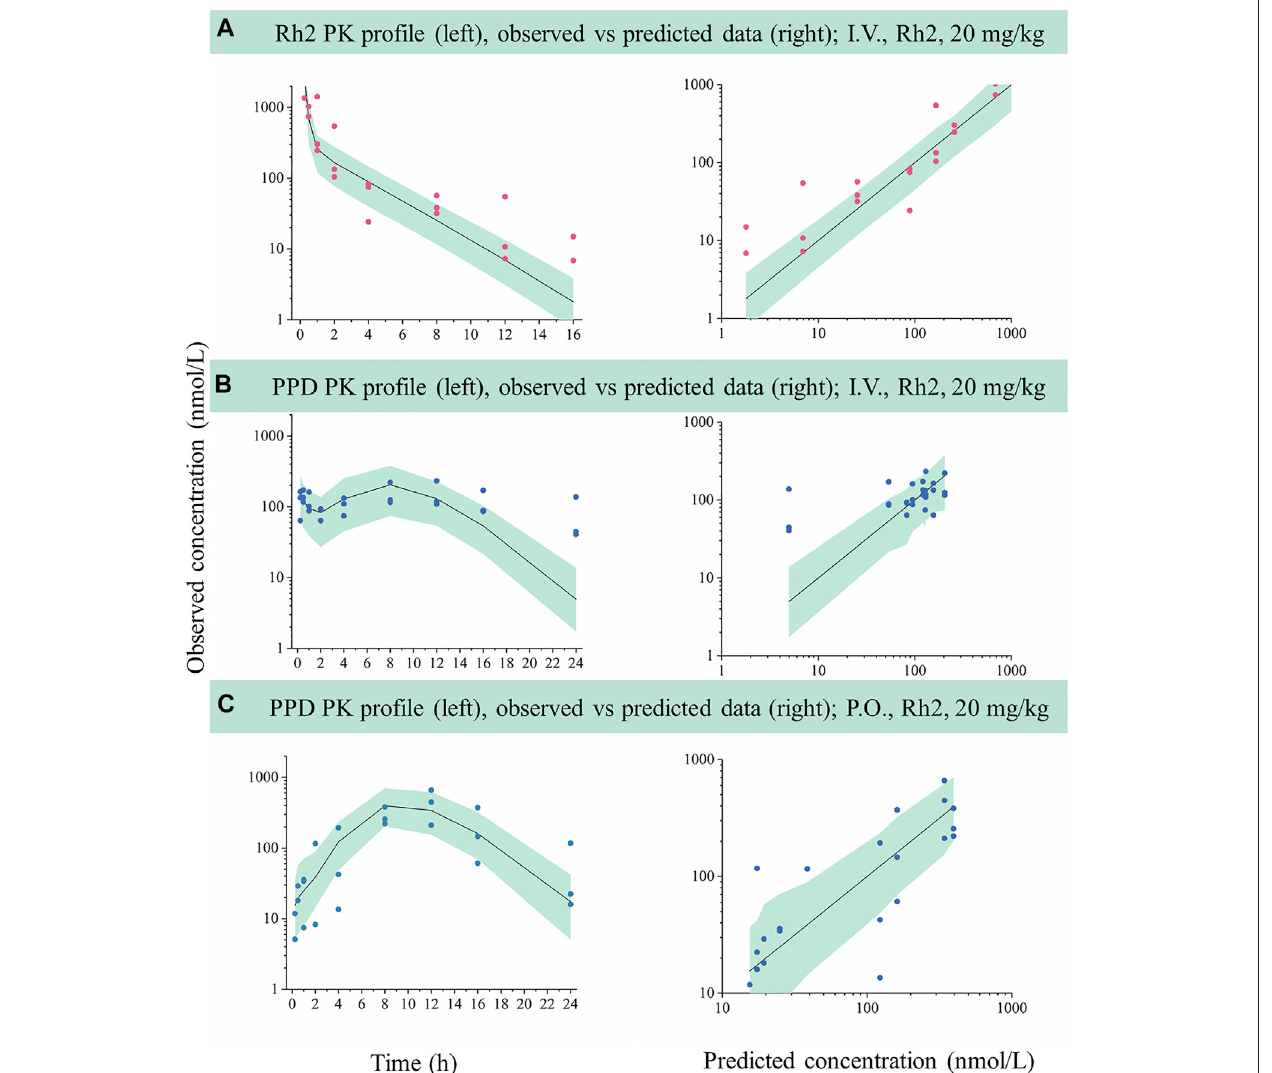
FIGURE 3 | External evaluation of the developed mechanistic pharmacokinetic model using the observed data from 20 mg/kg groups. Green areas represent the 90% model prediction interval between the 5th and 95th of percentiles, solid lines are the median model prediction (50th point of percentile), red symbols represent raw observations of Rh2, and blue symbols represent raw observations of PPD. (A) , Rh2 pharmacokinetic pro fi le after I.V. administration of Rh2 at 20 mg/kg; (B) , PPD pharmacokineticpro fi leafterI.V.administrationofRh2at20 mg/kg; (C) ,PPDpharmacokineticpro fi leafterP.O.administrationofRh2at20 mg/kg.The90%model prediction intervals were predicted by the model developed by the data at 10 mg/kg. Most of the observed Rh2 or PPD concentrations lay within the predicted 5th and 95th percentiles with the majority of observations being evenly distributed around the median.